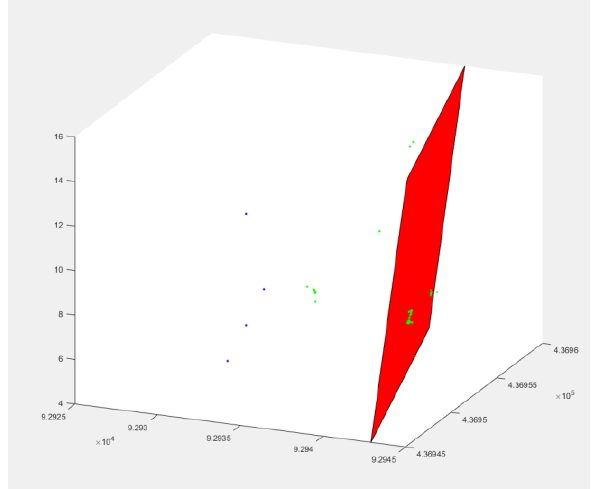
Figure 11. Sparse point cloud and fit plane of registration result in Figure 10; the pedestrian walked close to the wall and became part of the object points contributing to the plane. The tree in the foreground can be clearly distinguished from the façade points